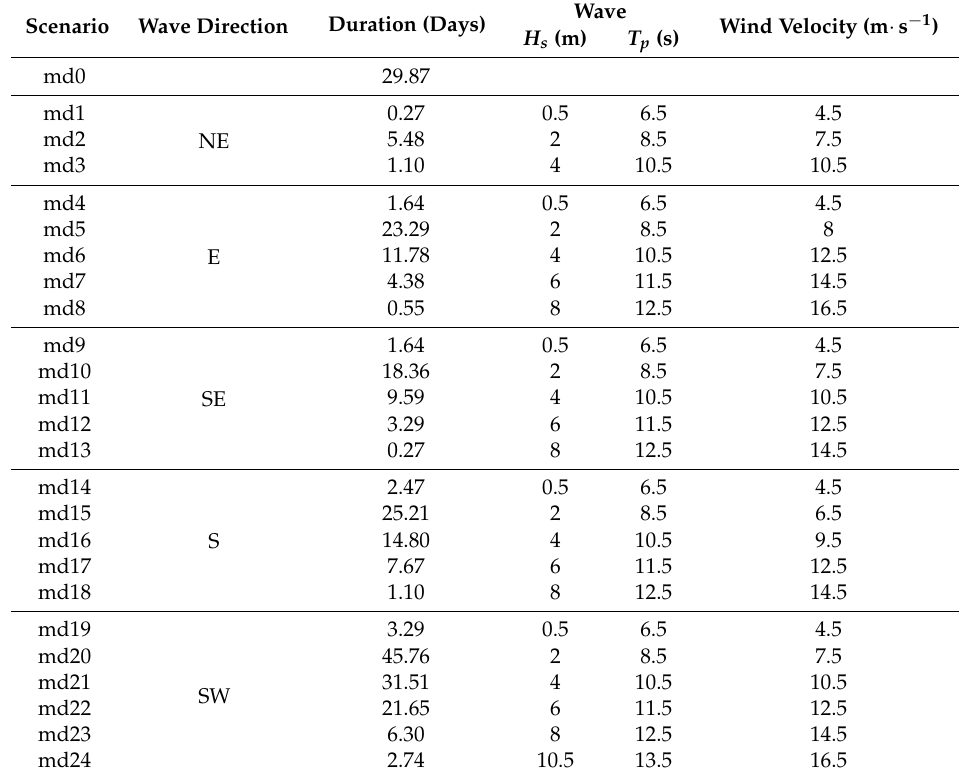
Table 1. Scenario simulations in the low flow season (December to August).